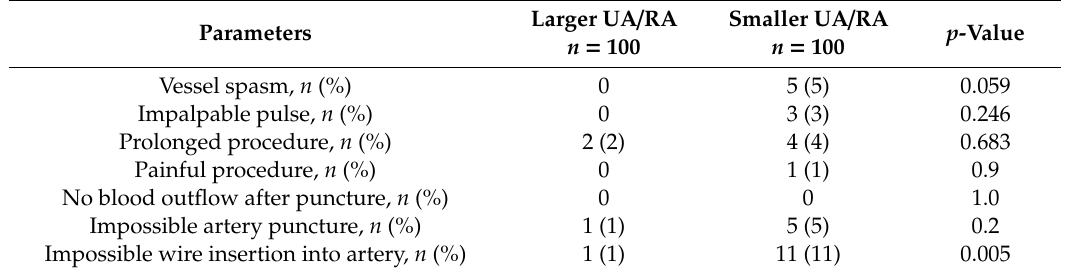
Table 5. The main reasons of crossover in the larger and smaller group.